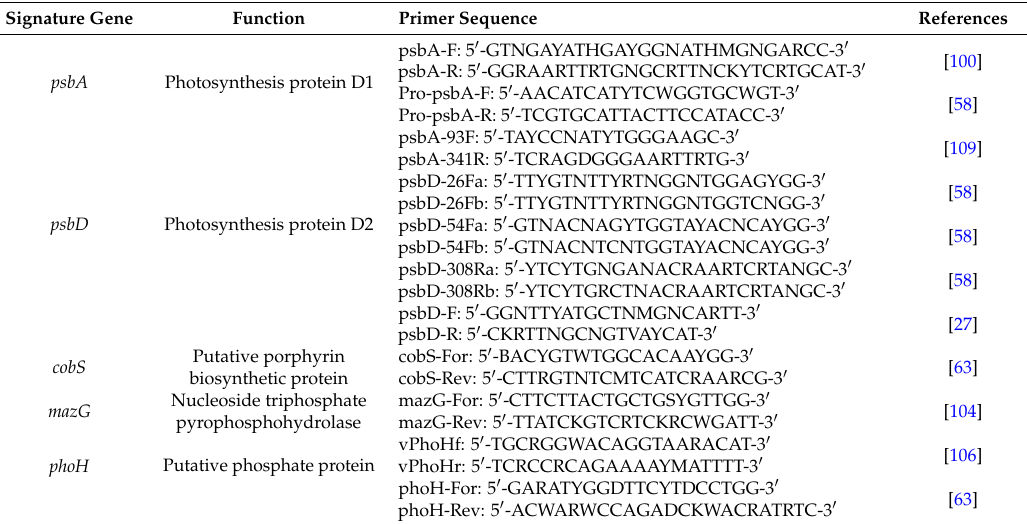
Table 1. Primer list of host-derived metabolic genes described in this